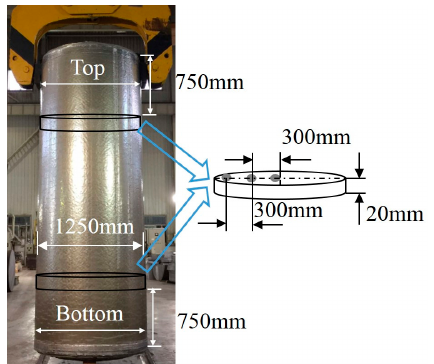
Figure 2. The manufactured large-scale cylindrical 2219 Al alloy ingot and the schematic diagram of the sampling method.